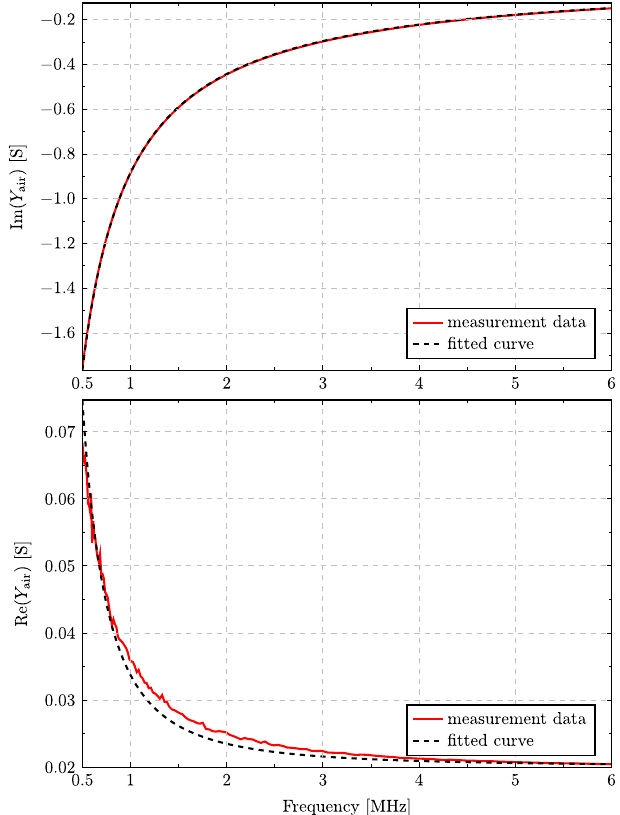
FIG. 4. Imaginary part (above) and real part (below) of the of the empty cavity as a function of frequency for admittance Y air the reflection measurement. The fitted curve (black dashed curve) 180 nH and R 17 . 5 m Ω as obtained by is shown with L air ¼ cav ¼ a fit to Eq. (10).